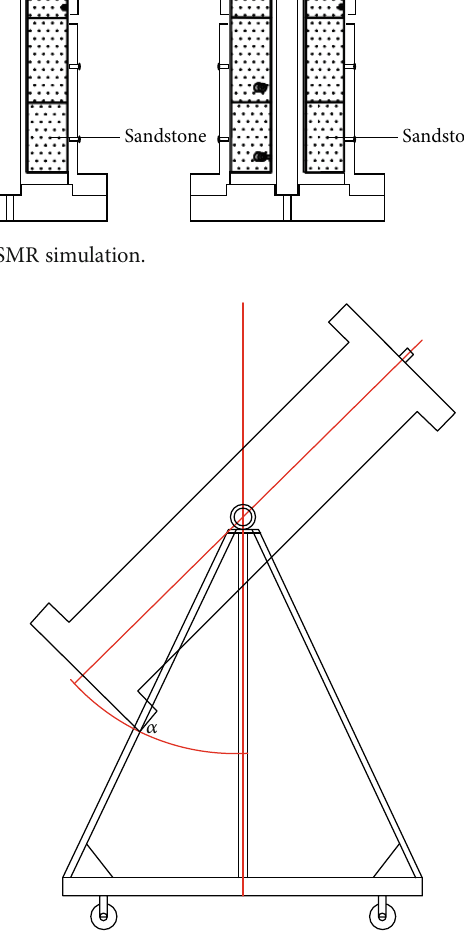
Figure 2: Schematic diagram of dynamic rotation of the